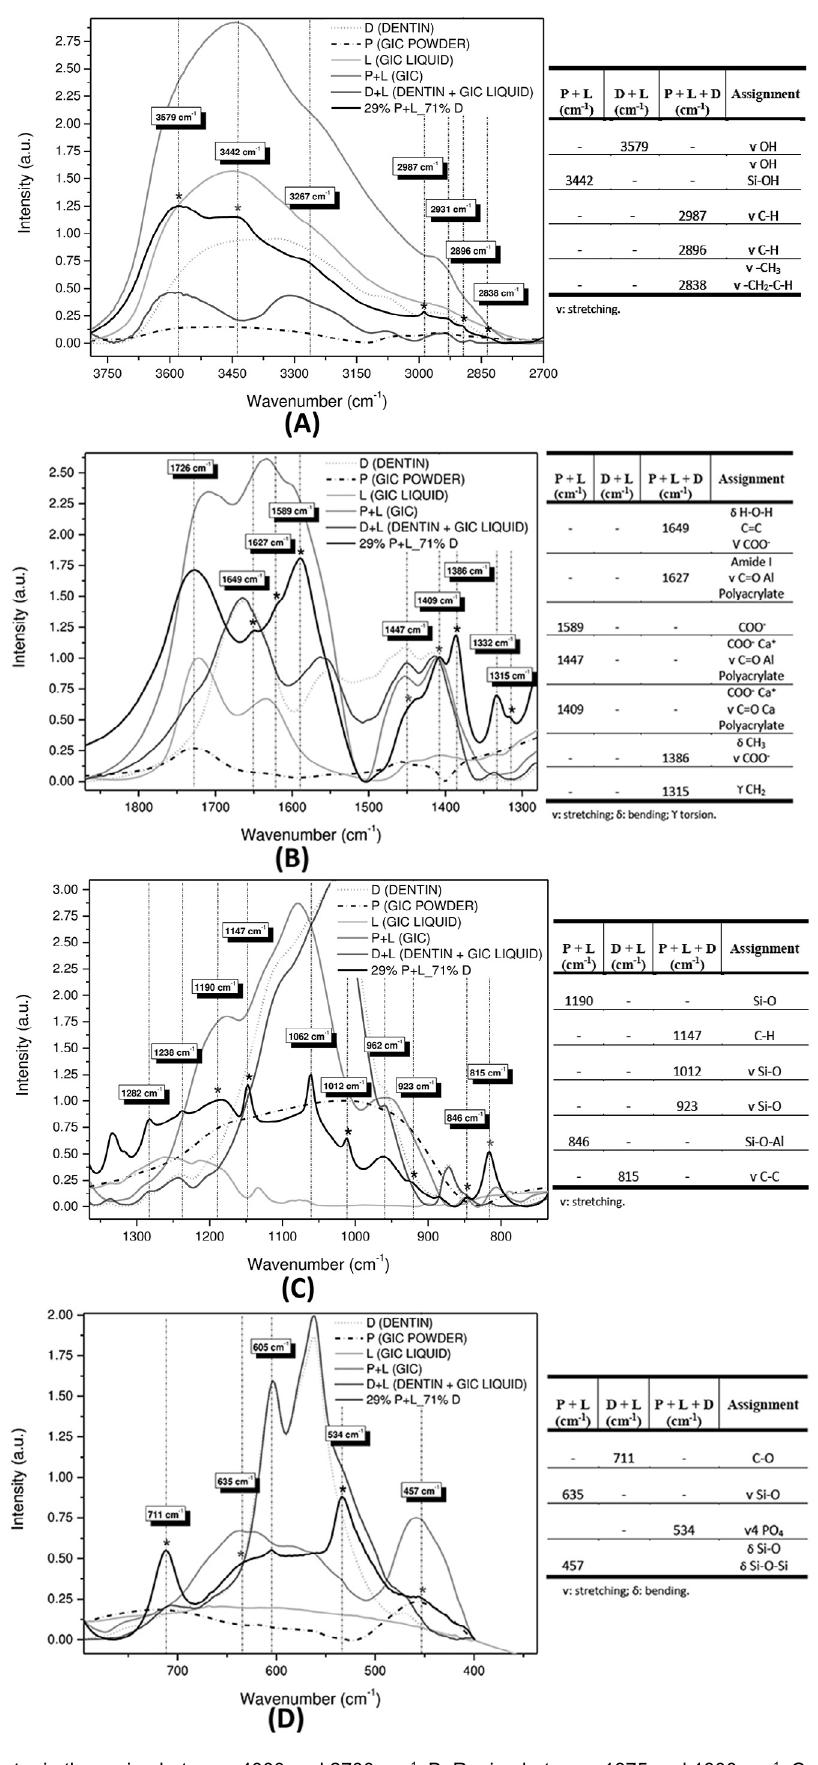
Figure 3- A: FTIR spectra in the region between 4000 and 2700 cm -1 ; B: Region between 1875 and 1300 cm -1 ; C. Region between 1300 and 750 cm -1 ; D: Region between 750 and 350 cm -1 . The tables show the FTIR bands of the identified functional